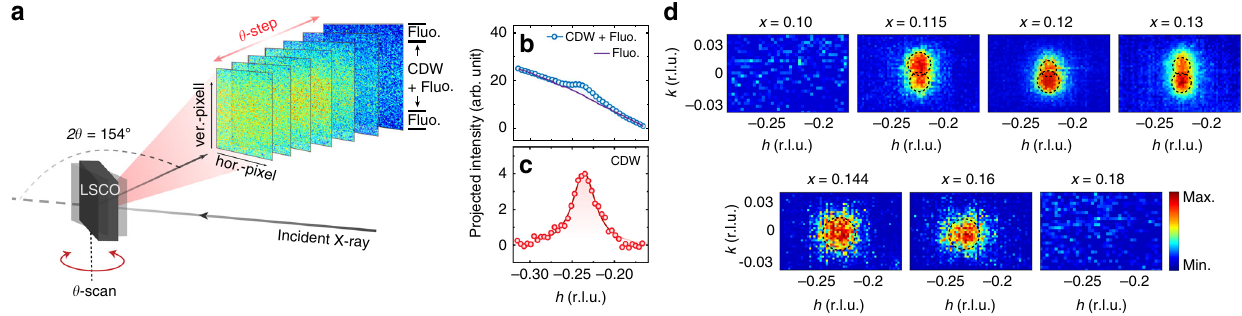
Fig. 2 RSXS measurements on LSCO. a A schematic sketch showing the RSXS experimental setup. The top and bottom parts in each CCD image are regarded as the fl uorescence (Fluo.) background. b The projected intensity pro fi les along the h -direction at both the CDW area ( k ~ 0 r.l.u.) and fl uorescence area ( k ~ ± 0.04 r.l.u.). c The CDW pro fi le after subtracting the fl uorescence background. The data in ( b ) and ( c ) is for x = 0.13 sample measured at 23 K. d Scattering patterns for various LSCO samples after subtracting the background. Measurements were taken at respective T c . The dashed circles outline the intensity contour